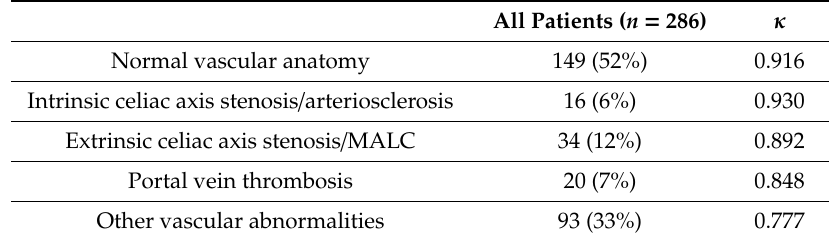
Table 1. Vascular evaluation based on preoperative contrast-enhanced computer tomographies